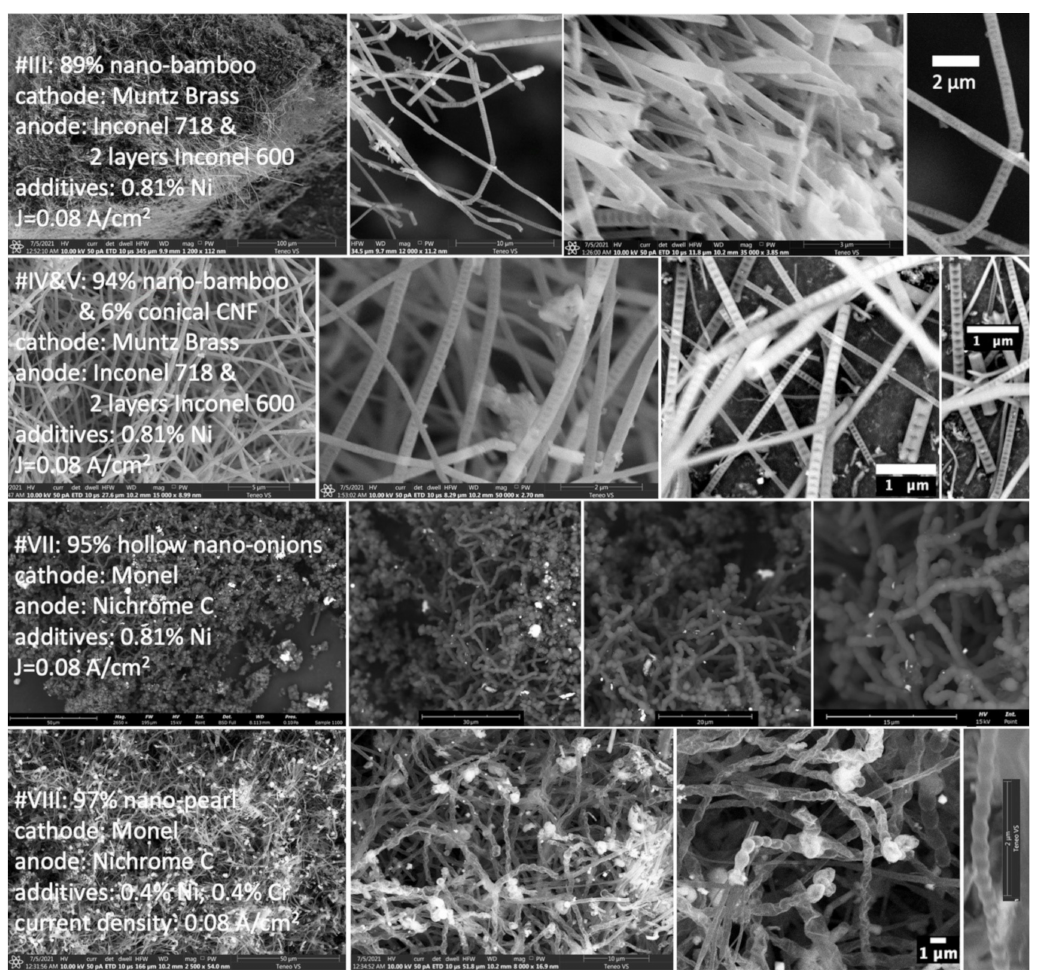
Figure 2. SEM of the synthesis product of nano-bamboo and nano-pearl allotropes of carbon by electrolytic splitting of CO 2 in 770 ◦ C Li 2 CO 3 . Moving left to right in the panels, the product is analyzed by SEM with increasing magnification. Scale bars in panels (starting from left) are for panels U: 100, 10, 3 µ m (different electrolysis) and 2 µ m; for panels T: 5, 2, 1 and 1 µ m; for panels 11: 50, 30, 20 and 15 µ m; for panels X: 50 µ m 10, 1 and 2 µ